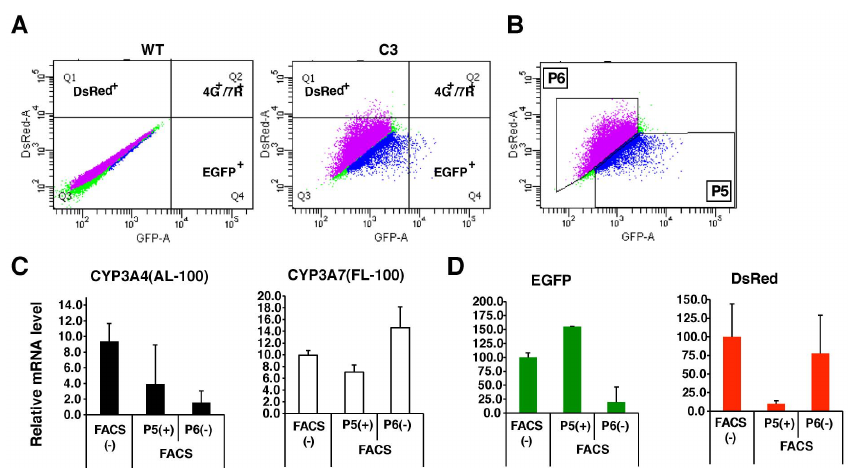
Figure 5. FACS-mediated isolation of CYP3A4-expressing hepatocytes from differentiated transgenic HepaRG cells according to EGFP fluorescence. (A) FACS analyses showing the remarkable increase in EGFP-positive cells or DsRed-positive cells in the transgenic HepaRG C3 cell population in comparison to the HepaRG WT cell population. Cells double-positive for EGFP and DsRed (4G + /7R + ) were not detected. (B) Cells were separated into two fractions: P5( + ), a fraction enriched with EGFP-positive cells and P6( 2 ), a fraction enriched with DsRed-positive cells. (C) Relative mRNA levels of CYP3A4 (AL=100) and CYP3A7 (FL=100) in sorted P5( + ), sorted P6( 2 ) cells, and unsorted cells (FACS( 2 )). Graphs show the mean 6 SD (n=3). (D) Relative mRNA levels of EGFP and DsRed in sorted P5( + ) and P6( 2 ) cells (levels in unsorted cells (FACS( 2 )) were set at 100). Graphs show the mean 6 SD (n=3).